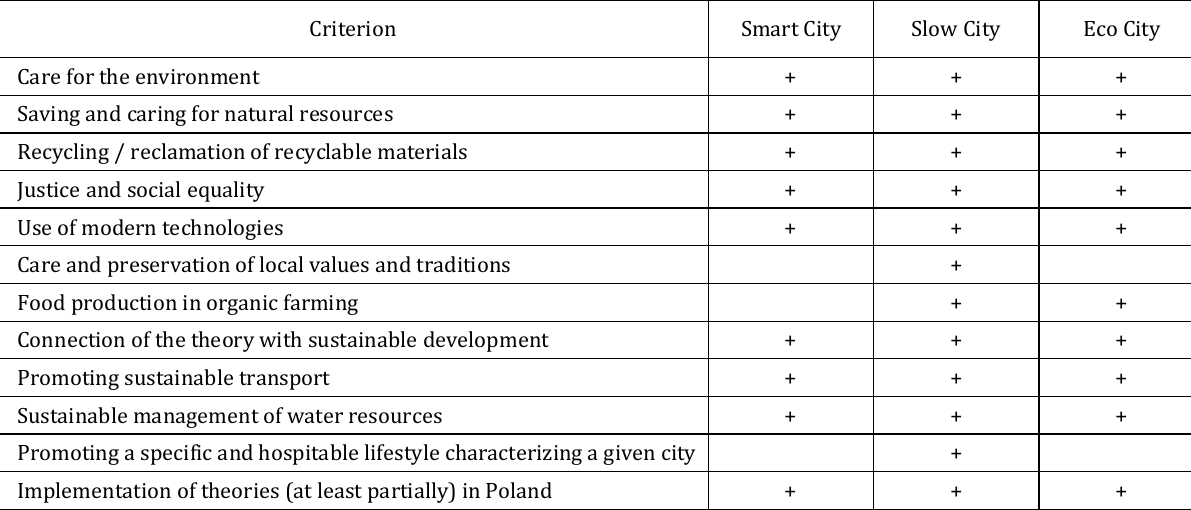
Table 2. Evaluation of the Smart City, Slow City and Eco City